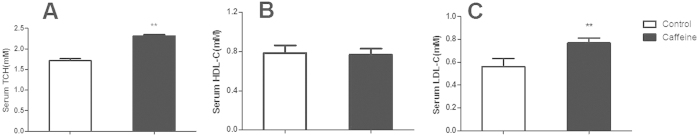
Changes in serum cholesterol concentrations in prenatal caffeine exposure (PCE) male offspring fed post-weaning high-fat diet.(A): total cholesterol concentration (TCH); (B): high-density lipoprotein-cholesterol (HDL-C) concentration; (C): low-density lipoprotein-cholesterol (LDL-C) concentration. Mean ± S.E.M., n = 8. **P < 0.01 vs. control.